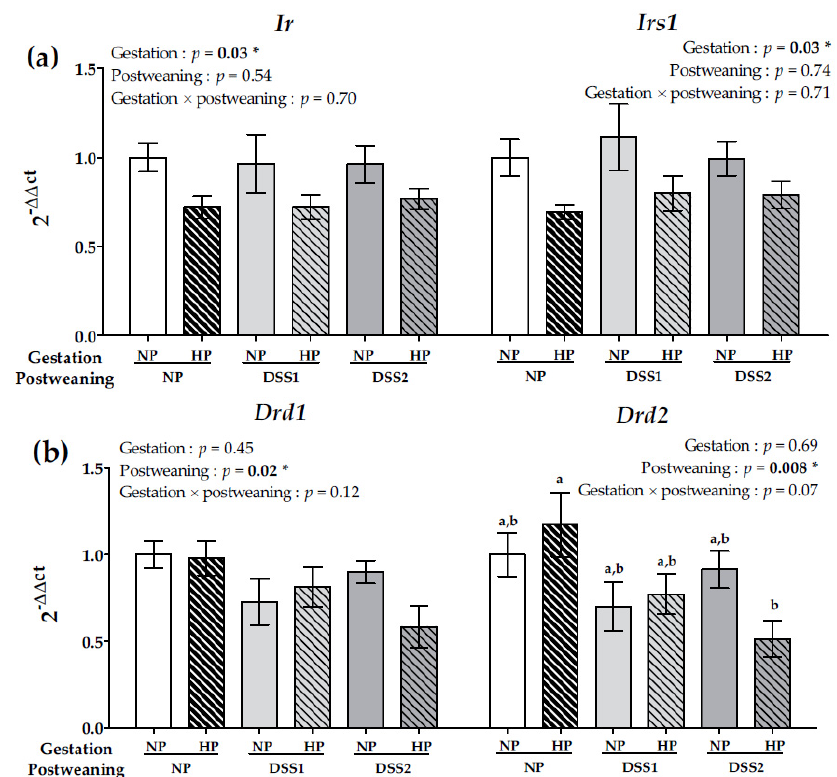
Figure 5. Gene expression in NAcc of Drd1 and Drd2 ( a ) and gene expression in liver of IR and IRS1 ( b ) on data collected on PND105. Data are means ± SEMs. Effects of diets were tested within model W (*, p < 0.05). Means that are significantly different ( p < 0.05) according to the post-hoc test have different letters ( a or b ). Drd1 and 2 , Dopamine receptors 1 and 2; IR, Insulin receptor; IRS1, Insulin receptor substrate 1; PND, Post-natal Day; NP, Normal-Protein (control); HP, High-Protein; DSS1, Dietary Self-Selection 1 (P and G/L in 2 different cups); DSS2, Dietary Self-Selection 2 (P, G and L in 3 different cups). Table 4. Gene expression in liver on PND105.